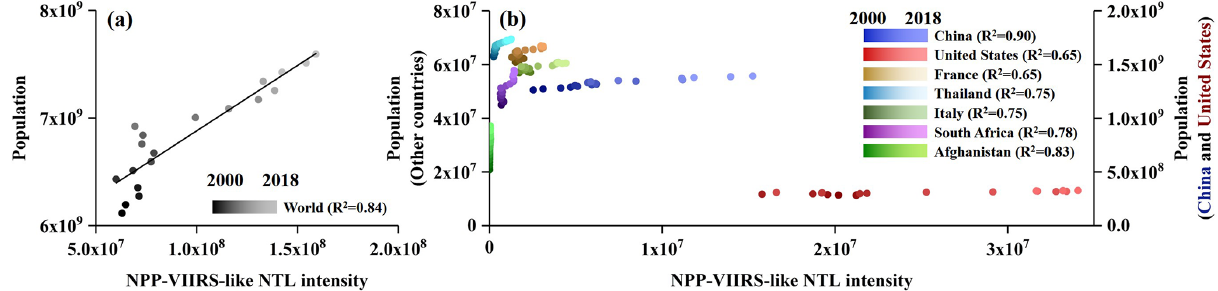
Figure 13. Comparison of total population with total NTL intensity for (a) the globe and (b) seven representative countries.